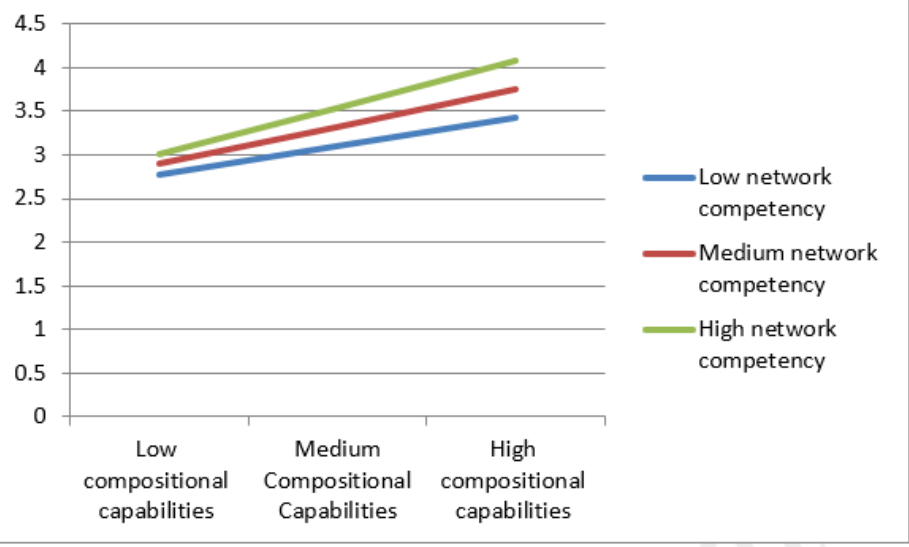
Figure 2: Moderating regression of network competency on to compositional capability and firm’s